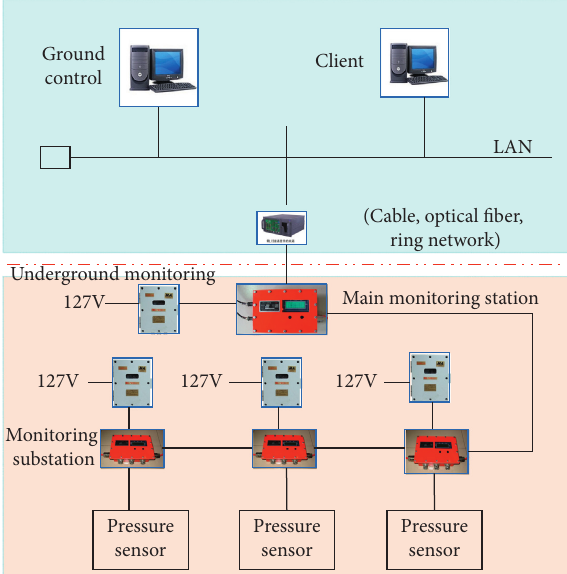
Figure 10: Monitoring system composition.